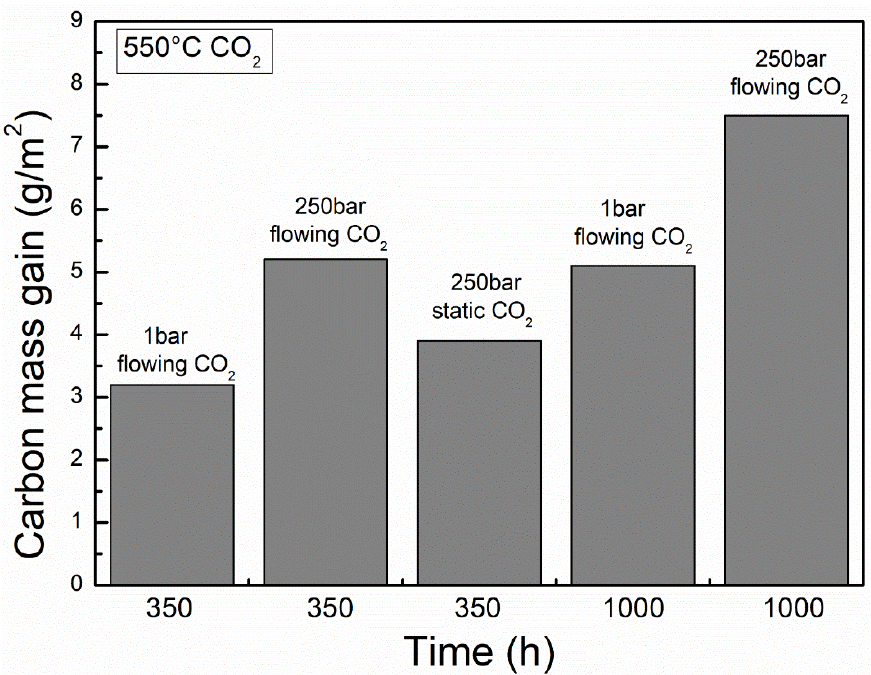
Figure 20. The carbon mass gain of 9Cr CEA (FMs T91) samples vary with exposure time and experimental conditions. Data were obtained from reference [17].